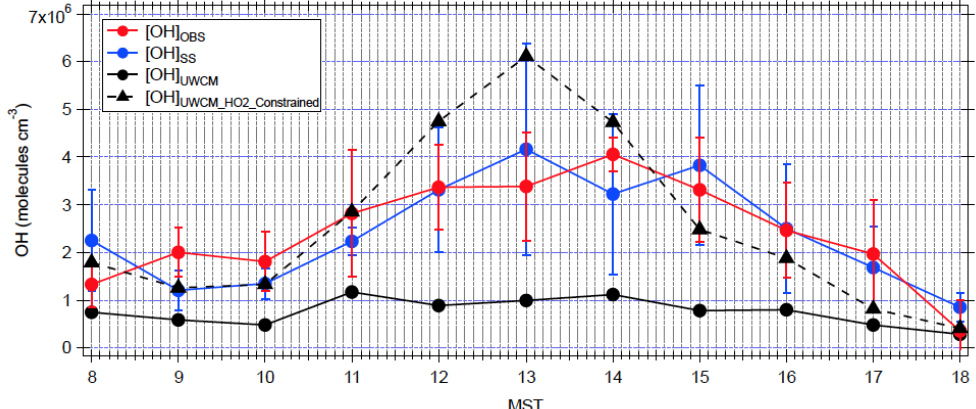
Figure 4. A correlation plot with [OH] MEA and [OH] SS (red circles) and a 1:1 line (dashed line). The error bars on the regression line (red) represent uncertainties of [OH] MEA and [OH] SS ) for 16 to 19 August 2010. 2 Constrained